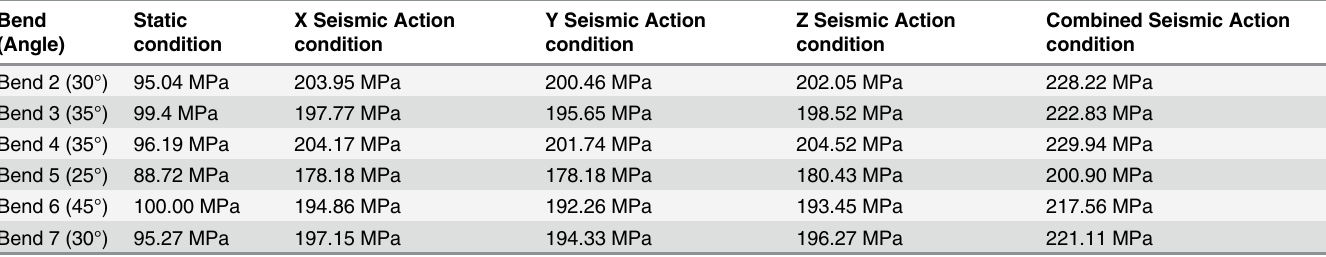
Table 10. Comparison of stresses of bends (25° – 45°) under different working